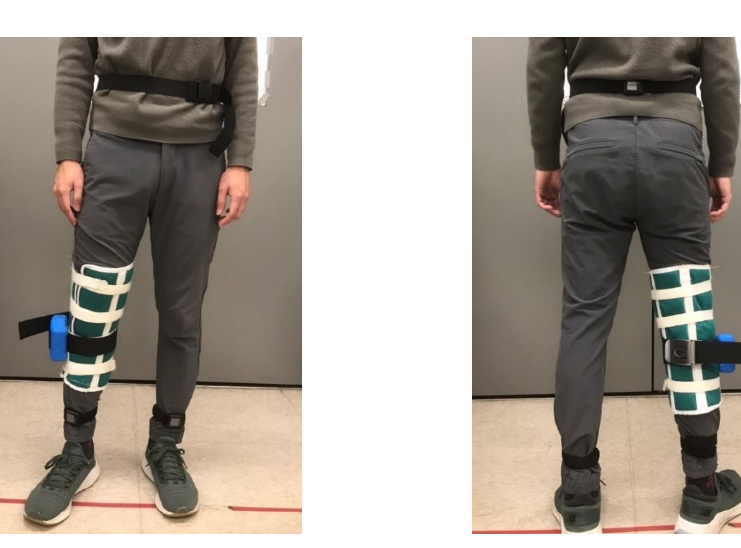
Figure 5. Rehab gaiter and IMUs’ location. Table 2. Testing results of the RNN model [24].